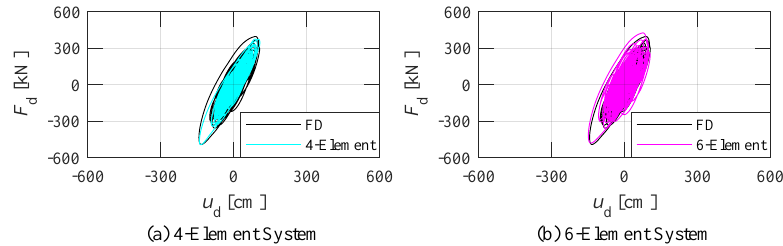
Figure 25. Comparison of hysteresis loop in the 2H-HH system (across-wind).